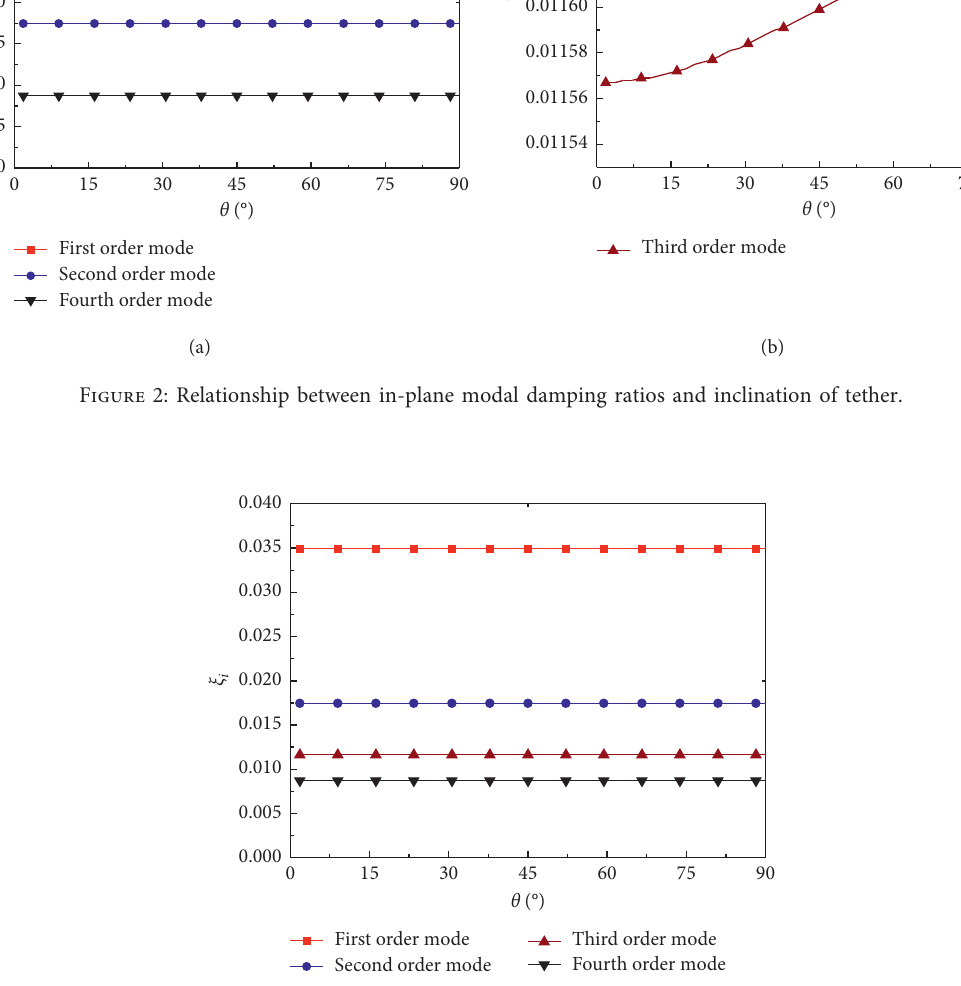
Figure 3: Relationship between out-of-plane modal damping ratios and inclination of